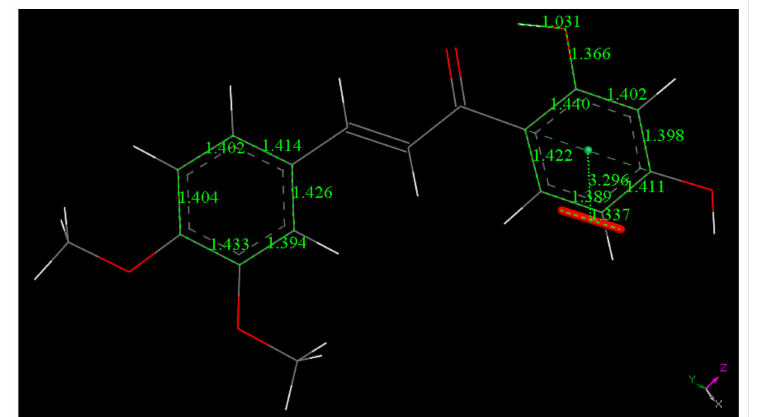
Figure 14. Result of DFT minimization for a π – π approach of superoxide on stacking DHDM chalcone ring A. The initial separation between both centroids was 3.50 Å. This is shortened to 3.296 Å, while the initial bond distance of O atoms in superoxide was 1.373 Å, shortened to 1.337 Å. Ring C–C bond lengths are not modified when this radical complex is formed, as seen comparing related data in Figure